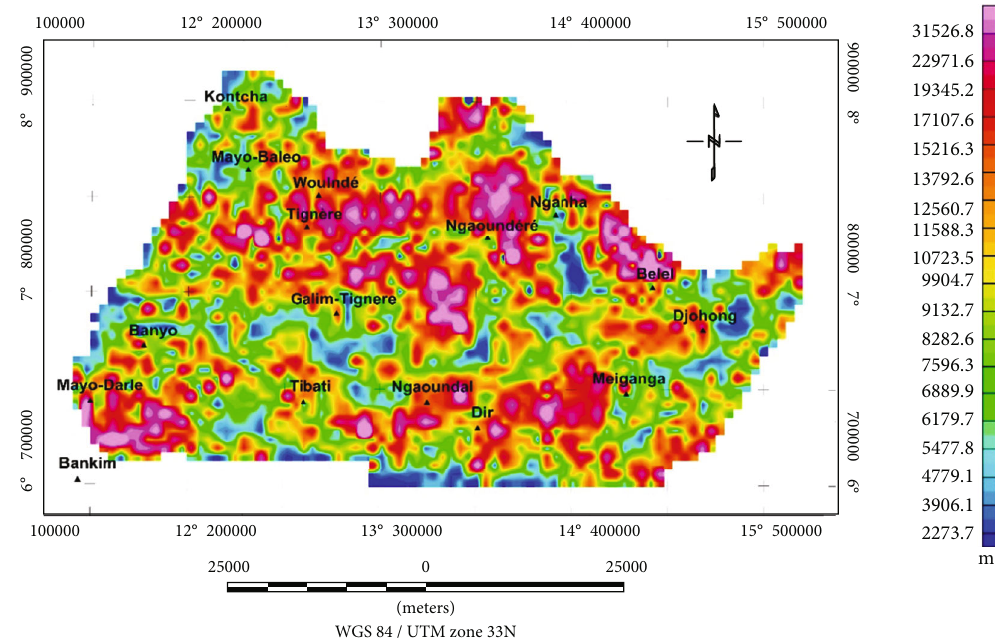
Figure 8: Depth chart of the study area calculated by the analytical signal (AS) method.